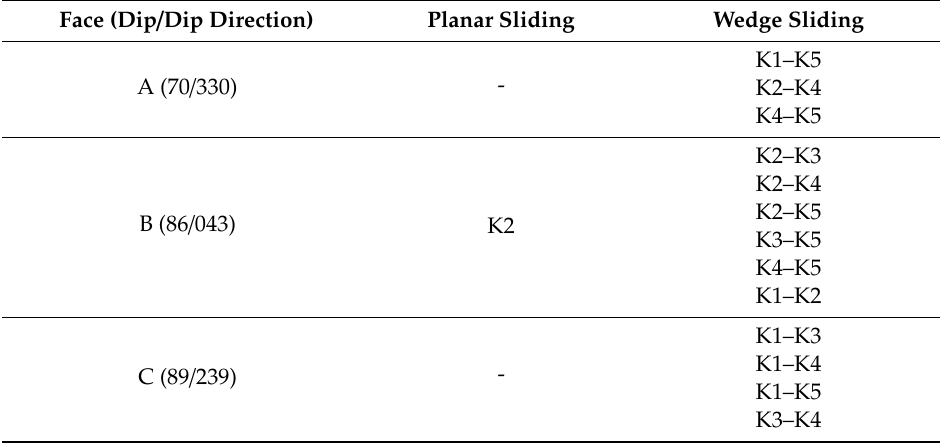
Table 4. Summary of potential failure mechanisms that may a ff ect excavation faces A, B, and